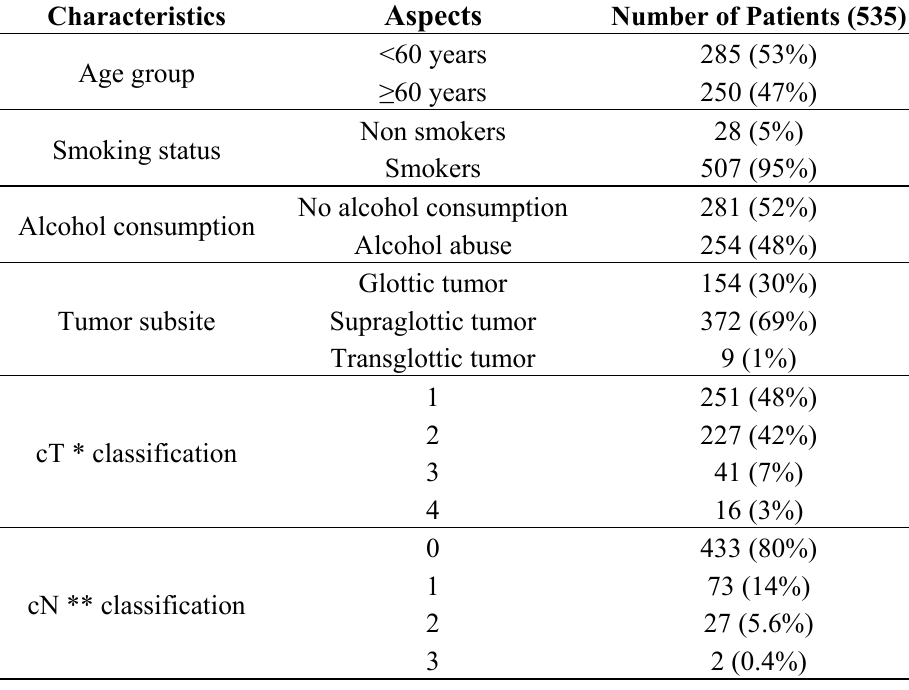
Table 1. Patient and tumor characteristics.